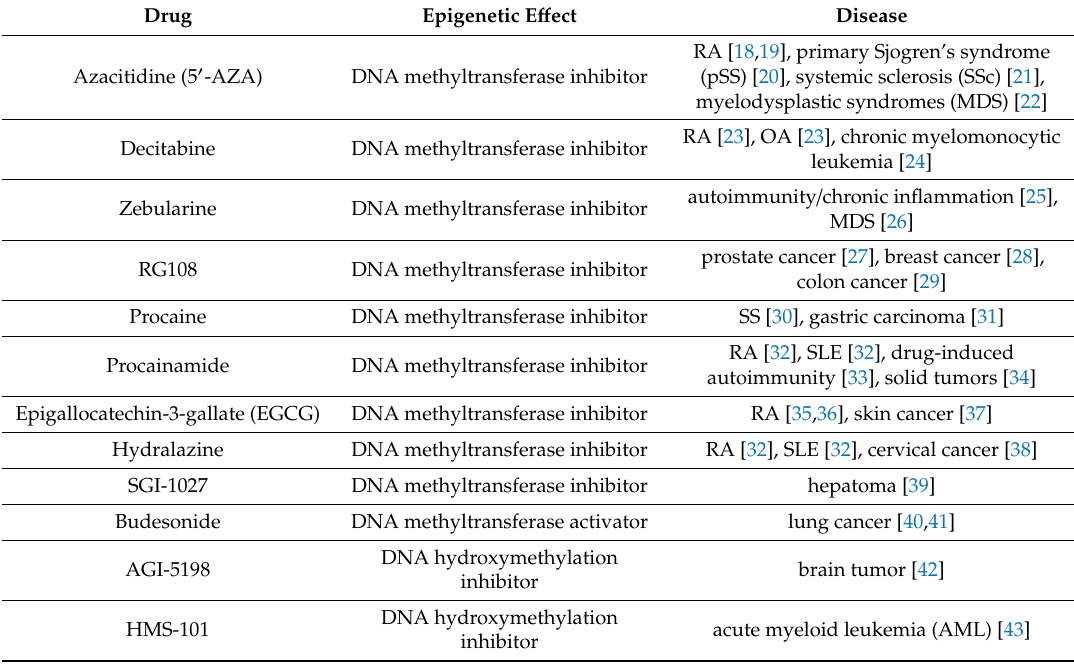
Table 1. Various drugs, inhibiting or activating DNA methylation and DNA hydroxymethylation, which are demonstrated in di ff erent